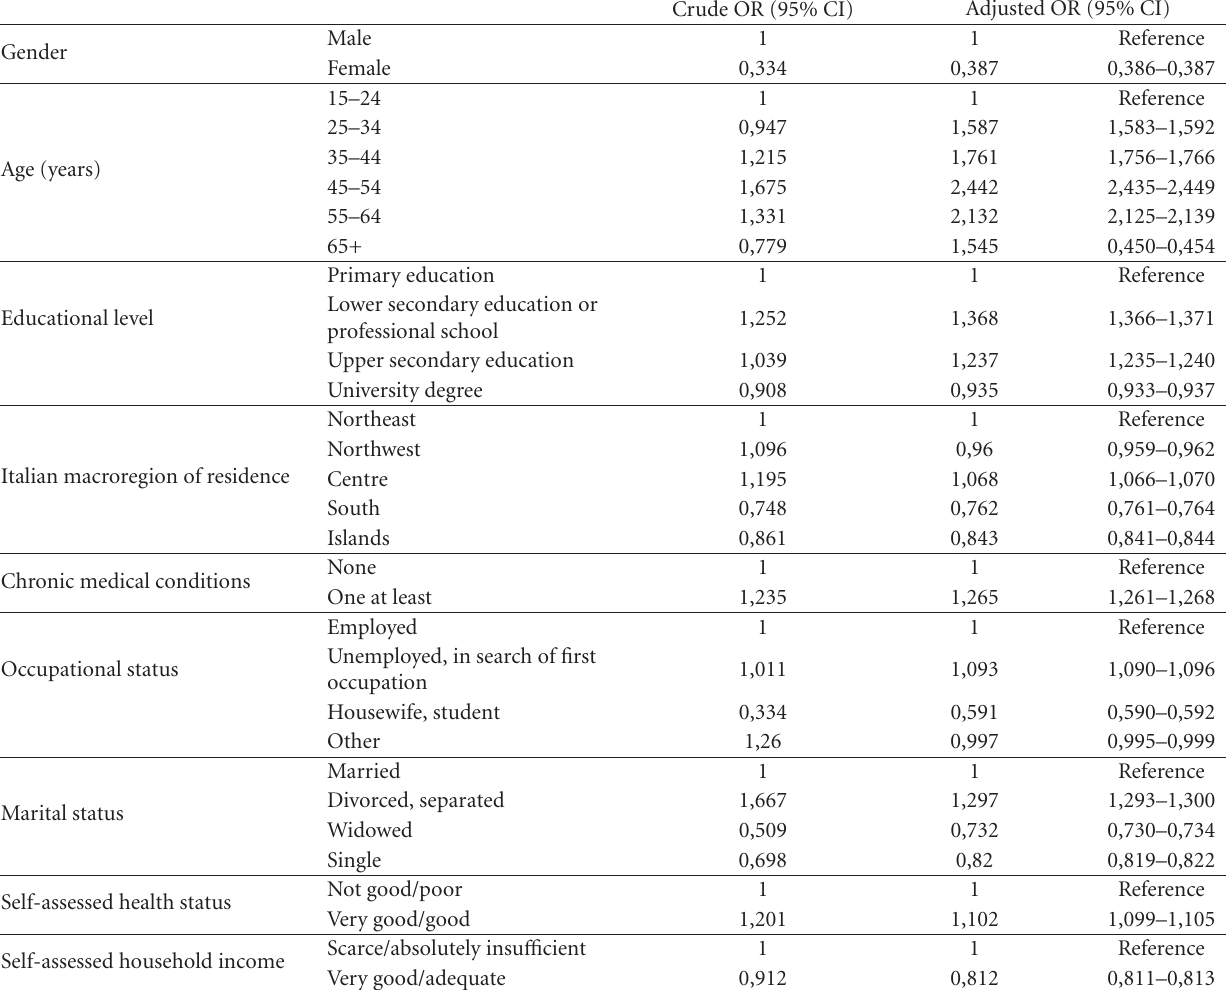
Table 3: Sociodemographic predictors of Ever smoking status —Multiple logistic regression model, year